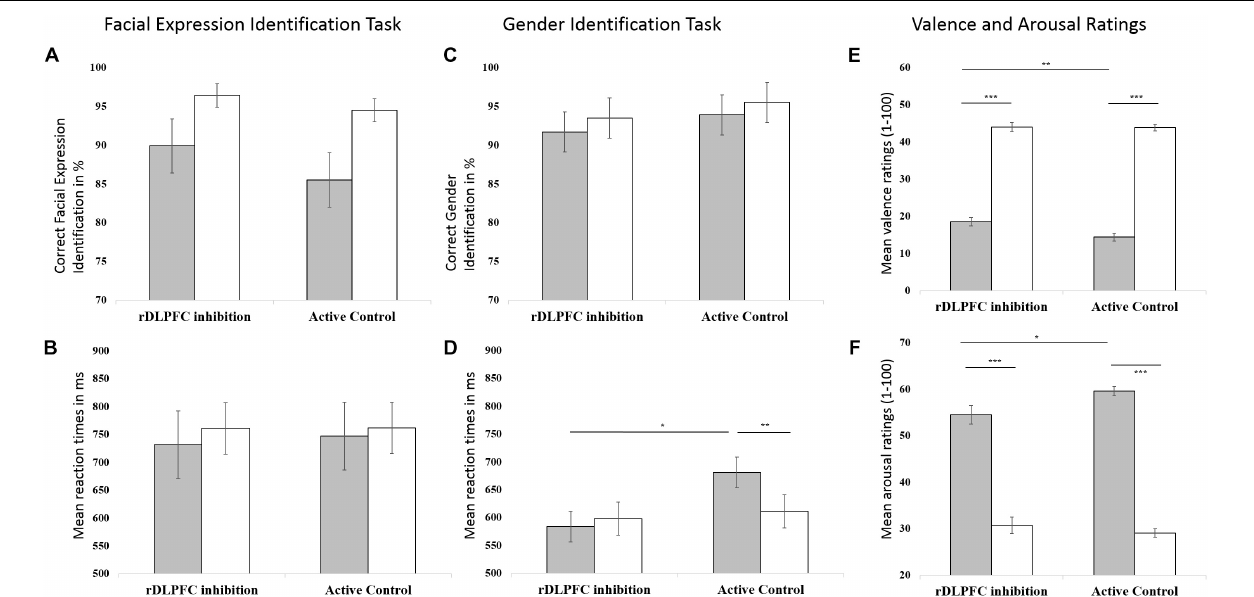
FIGURE 3 | Effects of stimulation (rDLPFC inhibition vs. Active Control) and valence (negative vs. neutral) on behavioral responses. Left column: (A) Mean response accuracies and (B) reaction times to negative (here: fearful; gray) and neutral (white) facial expressions in the Facial Expression Identification Task. Middle column: (C) Mean response accuracies and (D) reaction times to negative (here: fearful; gray) and neutral (white) facial expressions in the Gender Identification Task. Right Column: (E) Mean valence ratings and (F) arousal ratings in response to negative (gray) and neutral (white) images. Higher scores indicate more positive and higher arousal ratings, respectively. Error bars indicate the standard errors of the means. For significant interactions of valence and stimulation, results of post hoc t -tests (Bonferroni corrected) are indicated ( ∗ p < 0.05, ∗∗ p < 0.01, ∗∗∗ p < 0.001).